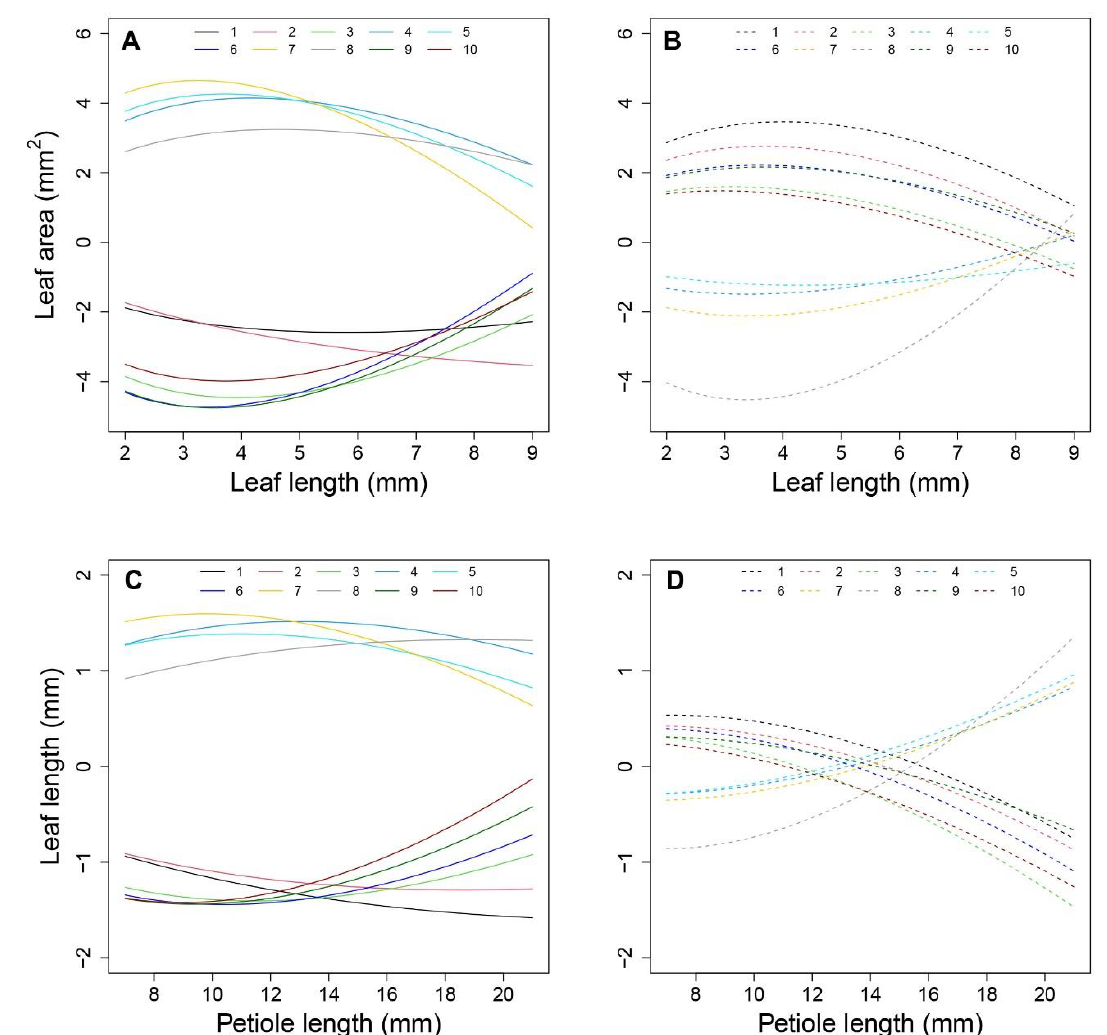
Figure 6. Additive effect with significant SNPs. ( A , B ) show the additive effect of shapeQTLs with 10 significant genes under low- and high-density conditions. Numbers 1–10 present genes AT1G17020.1, AT1G19850.1, AT2G03340.1, AT2G27110.1, AT3G59060.1, AT3G63300.1, AT4G16250.1, AT4G25420.1, AT5G28530.1 and AT5G40910.1, respectively. ( C , D ) show the additive effect of positionQTLs with 10 significant genes under low- and high-density conditions. Numbers 1-10 present AT1G29690.1, AT1G10240.1, AT1G51090.1, AT2G43010.1, AT3G22170.1, AT3G58850.1, AT4G18130.1, AT4G27430.1, AT5G38860.1 and AT5G51810.1, Table 2. Functional annotation of QTLs associated with allometry between the petiole length and leaf length.